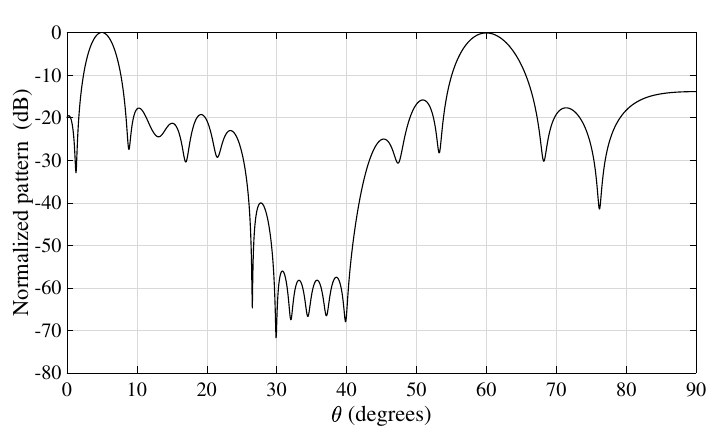
Figure 4. Second example: 3D pattern.